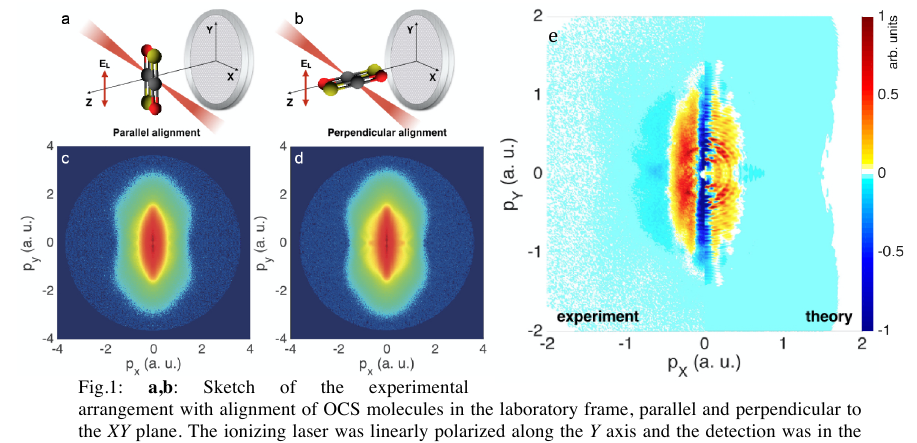
Fig.1: a,b : Sketch of the experimental arrangement with alignment of OCS molecules in the laboratory frame, parallel and perpendicular to the XY plane. The ionizing laser was linearly polarized along the Y axis and the detection was in the XY plane. c,d : Molecular-frame angle-resolved photoelectron spectra projected onto a 2D detector in a velocity map imaging spectrometer on a logarithmic scale. e : Measured (left) and computed (right) differential momentum distribution (parallel − perpendicular). The molecules were aligned in two different configurations, shown in Fig.1 a,b, with the molecular axis along the Y and Z axes, named parallel and perpendicular alignment, respectively. A second laser pulse, centered at 1300 nm, with a duration of 65 fs, and a peak intensity of 8·10 13 W/cm 2 , was used to singly ionize the OCS molecules. The ionizing laser pulse, E in Fig.1 a,b, was linearly polarized along the Y axis. The produced molecular- L frame angle-resolved photoelectron spectra (MF-ARPES) were recorded in a velocity map imaging (VMI) spectrometer with its detector parallel to the XY plane (Fig.1 c,d). In order to have a close comparison between the two different alignment cases, we performed a differential analysis by subtracting the two experimental spectra from each other. In Fig. 1 e (left half) the relative normalized difference, parallel minus perpendicular, is reported. Thus, positive signal in Fig. 1 e corresponds to a larger contribution from parallel alignment, while negative signal refers to a larger contribution from perpendicular alignment. A strong depletion along the vertical axis and two transversely offset broad lines of positive yield appear as main features. The depletion along the centerline is due to the node along the molecular axis of the degenerate Π highest occupied molecular orbital (HOMO) of OCS; it represents a forbidden direction of electron ejection [5]. The offset broad lines, instead, correspond to a larger transverse initial momentum, along the X